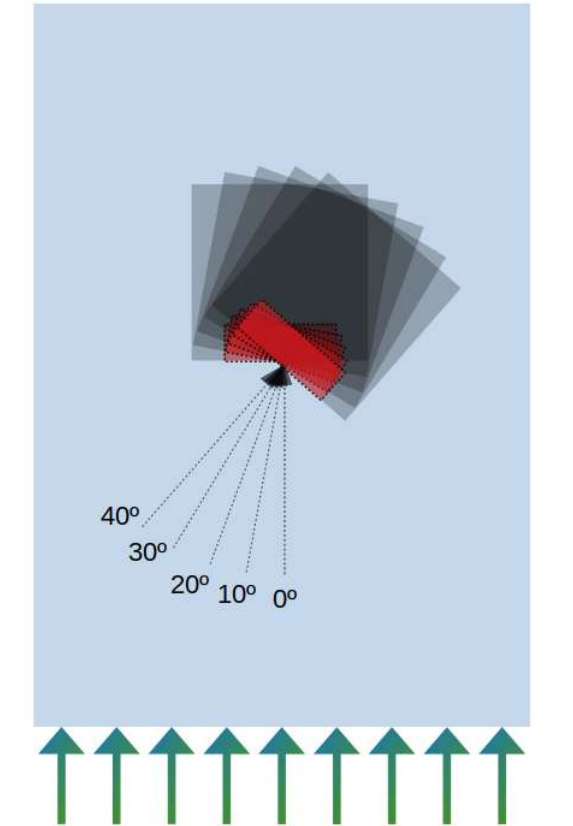
Figure 4. Scheme of the skew angle for our small scale experiment and the horizontal axis turbine with the incoming wind field (vectors above) in the wind tunnel. 0 ◦ corresponds to wind direction perpendicular to the